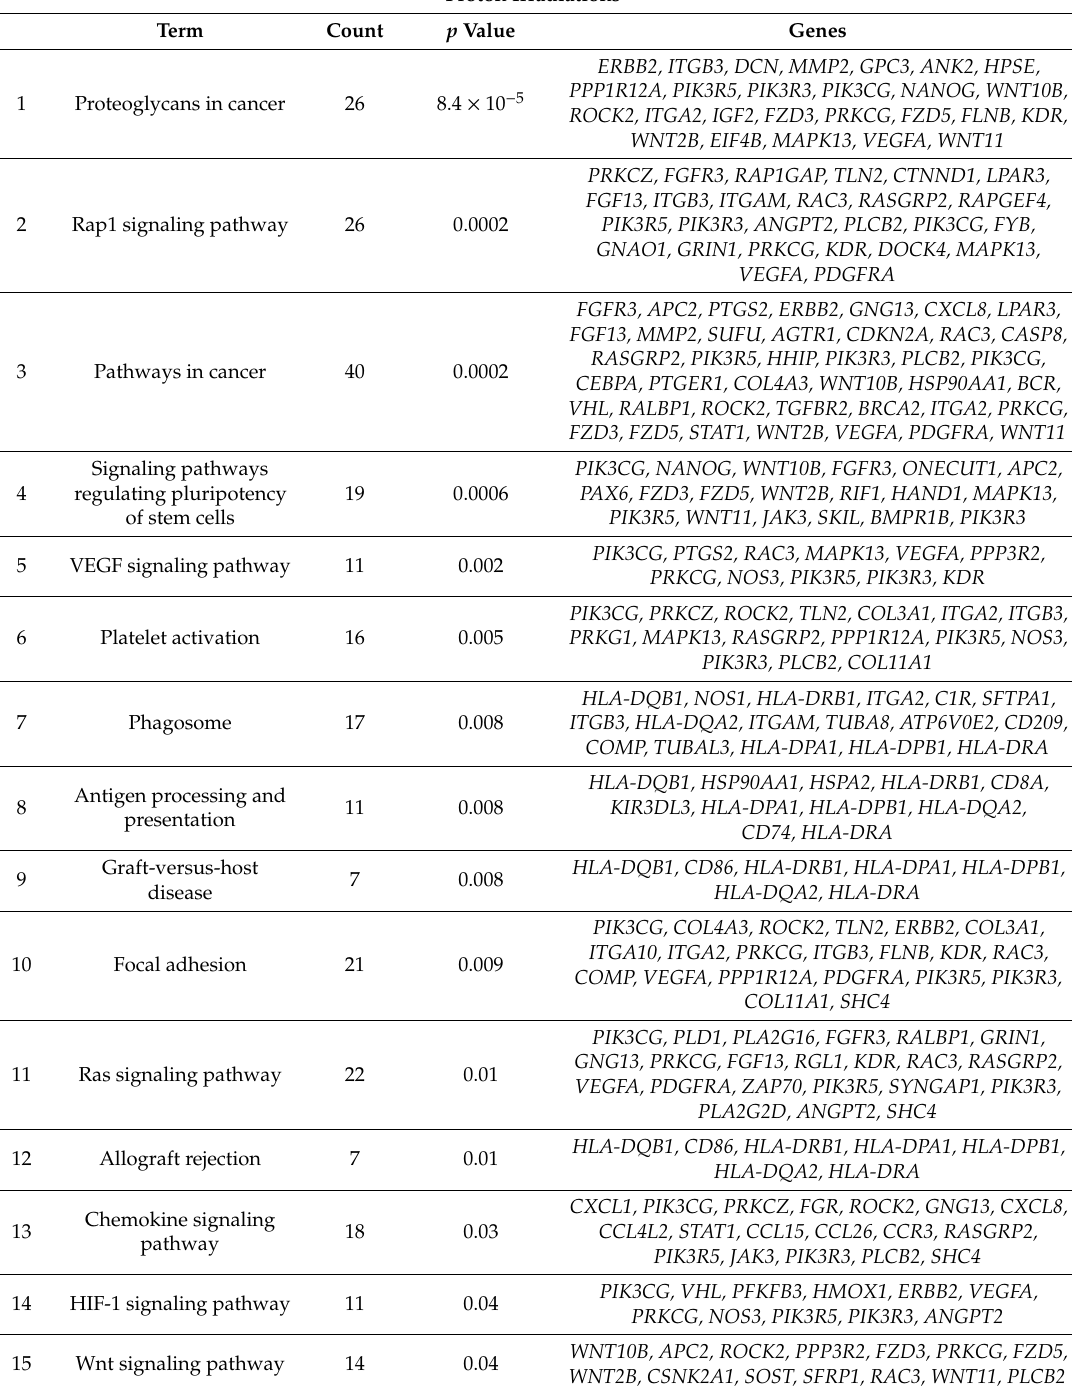
Table 4. GEPs DAVID analysis of MDA-MB-231 xenograft mice exposed to 9 Gy of proton irradiation. Top 15 Molecular Pathways of Di ff erentially Expressed Genes of MDA-MB-231 Xenograft Mice Exposed to 9 Gy of Proton